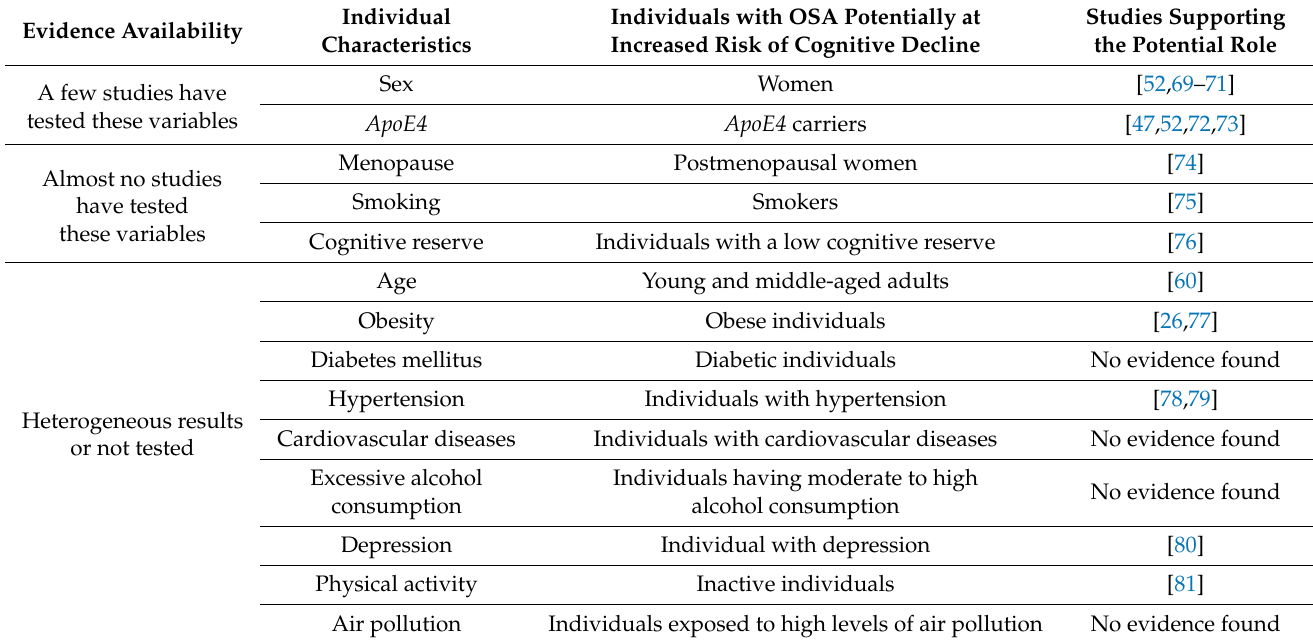
Table 1. Individual characteristics that could interact with OSA severity to predict risk of cognitive